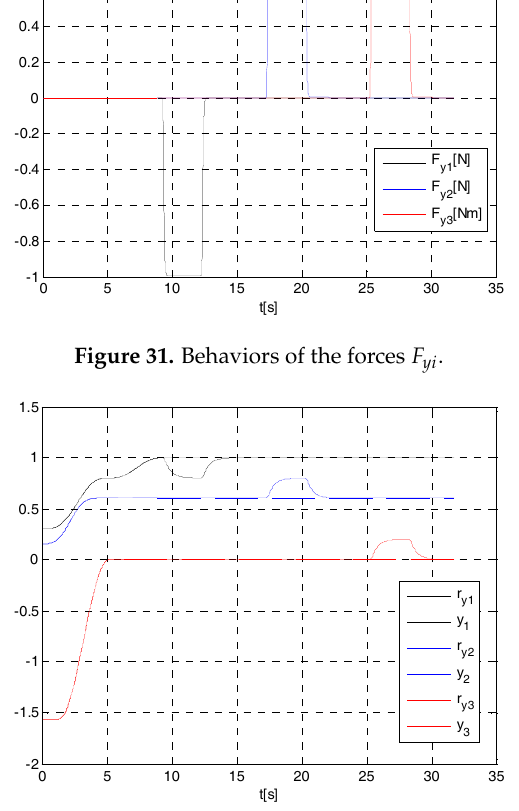
Figure 32. Behaviors of r yi and of y i assuming that the impedance is as shown in Figure 30a).